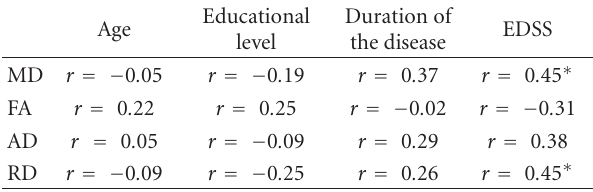
Table 2: Pearson’s correlation test evaluating possible correlations between DTI parameters and demographic characteristics of the sample.